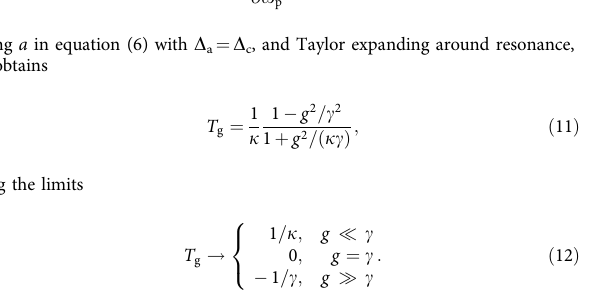
suppression of the latter when C becomes large.